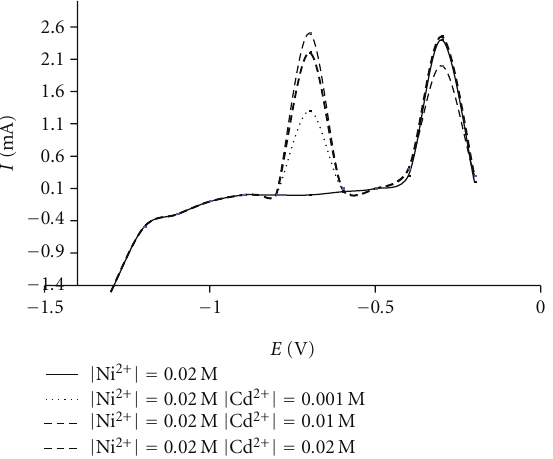
Figure 6: Anodic stripping voltammetry at a scan of 5 mV/s of a metallic solution containing | Na 2 SO 4 | = 0.5 M | H 3 BO 3 | = 0.8M at pH = 3.5.